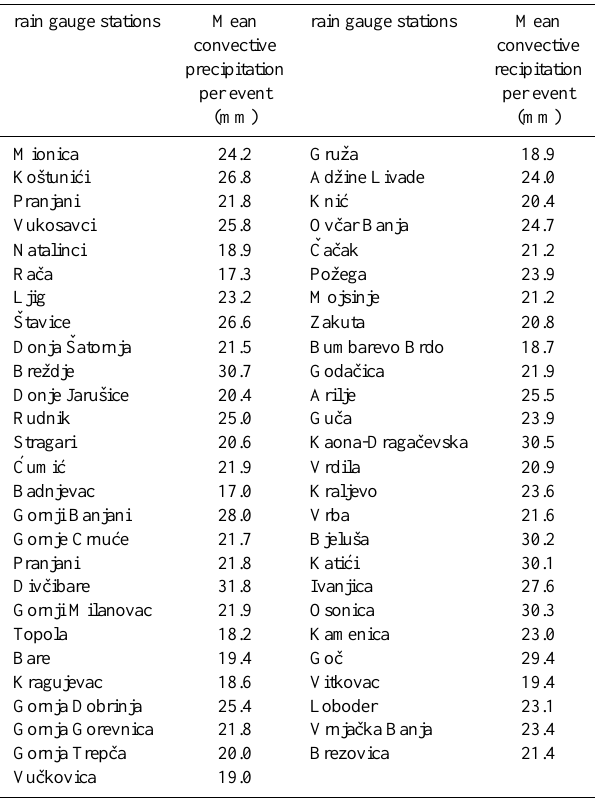
Table 2. Mean convective precipitation per event (in mm) at rain- gauge